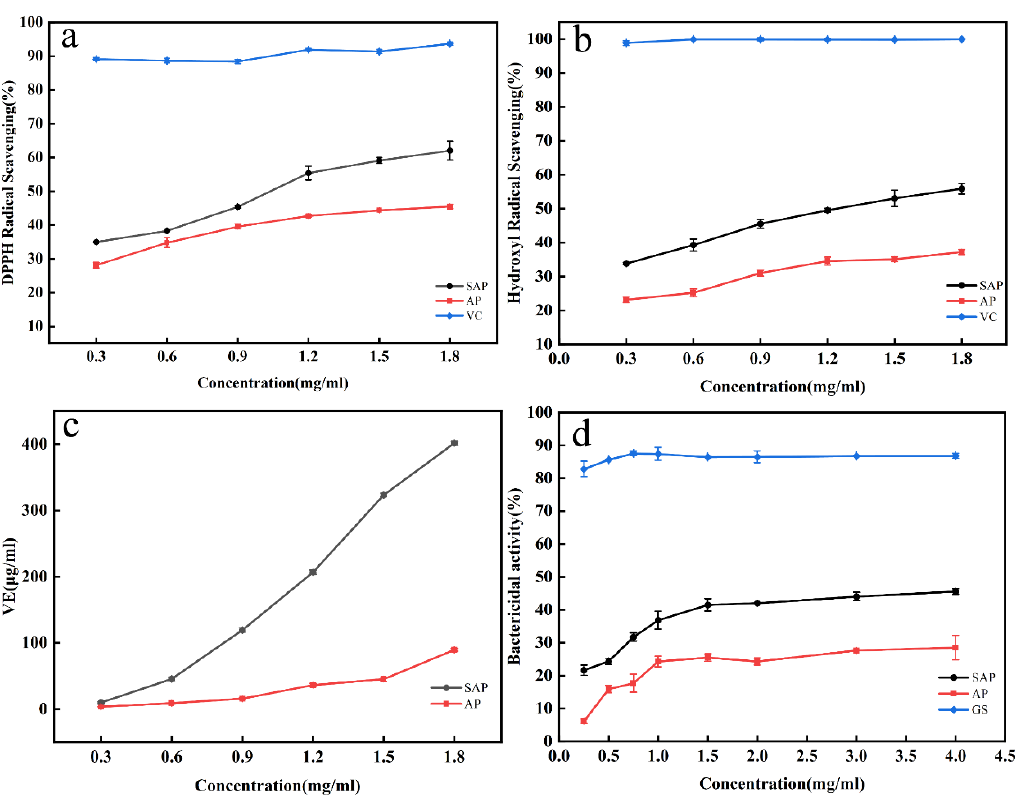
Figure 8. Biological activity. ( a ) Scavenging activity of AP, SAP, and VC at different concentrations for DPPH radicals. ( b ) Scavenging activity of AP, SAP, and VC at different concentrations for hydroxyl radicals. ( c ) The reducing power activity of AP and SAP at different concentrations. ( d ) Bactericidal activity of AP, SAP, and GS at different concentrations.